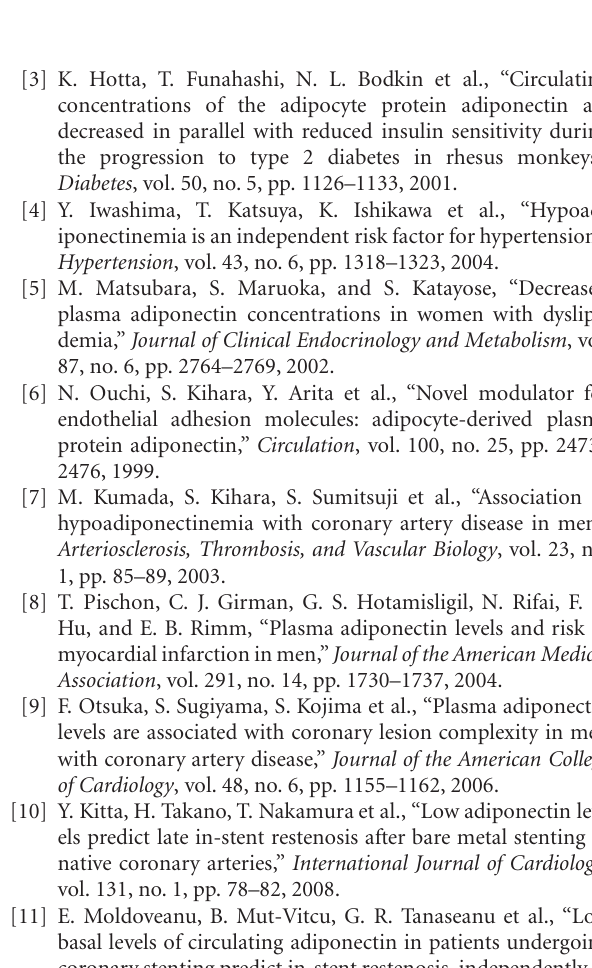
Figure 2: Hypoadiponectinemia directly promotes the pathological reactions in cardiovascular